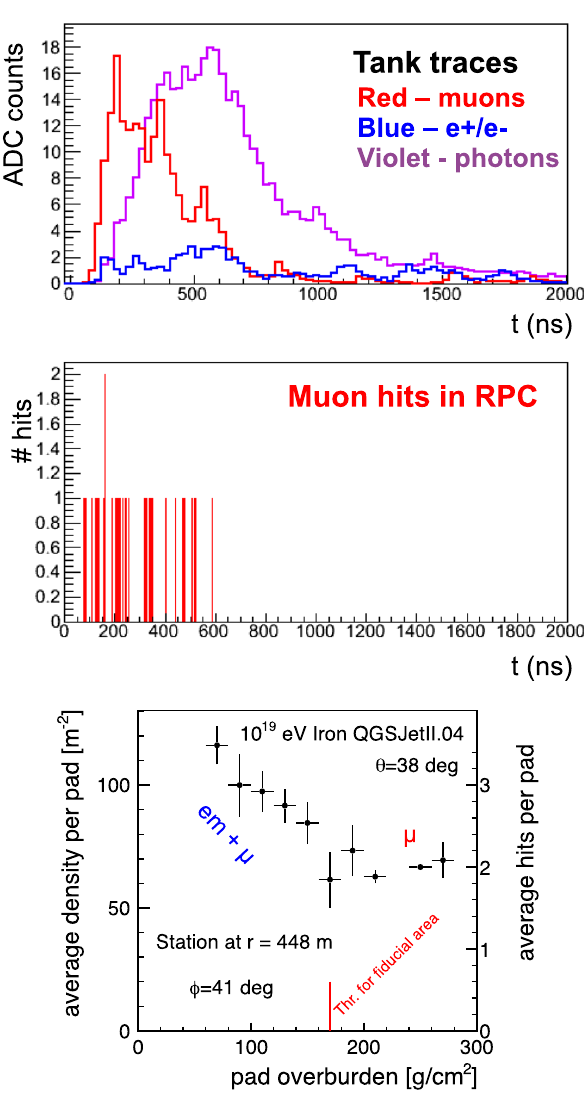
Fig. 5 Top: Example of a MARTA simulated trace – the simulated WCD and RPC traces are shown; Bottom: Separation of the electro- magnetic and muonic shower components in a simulated MARTA unit